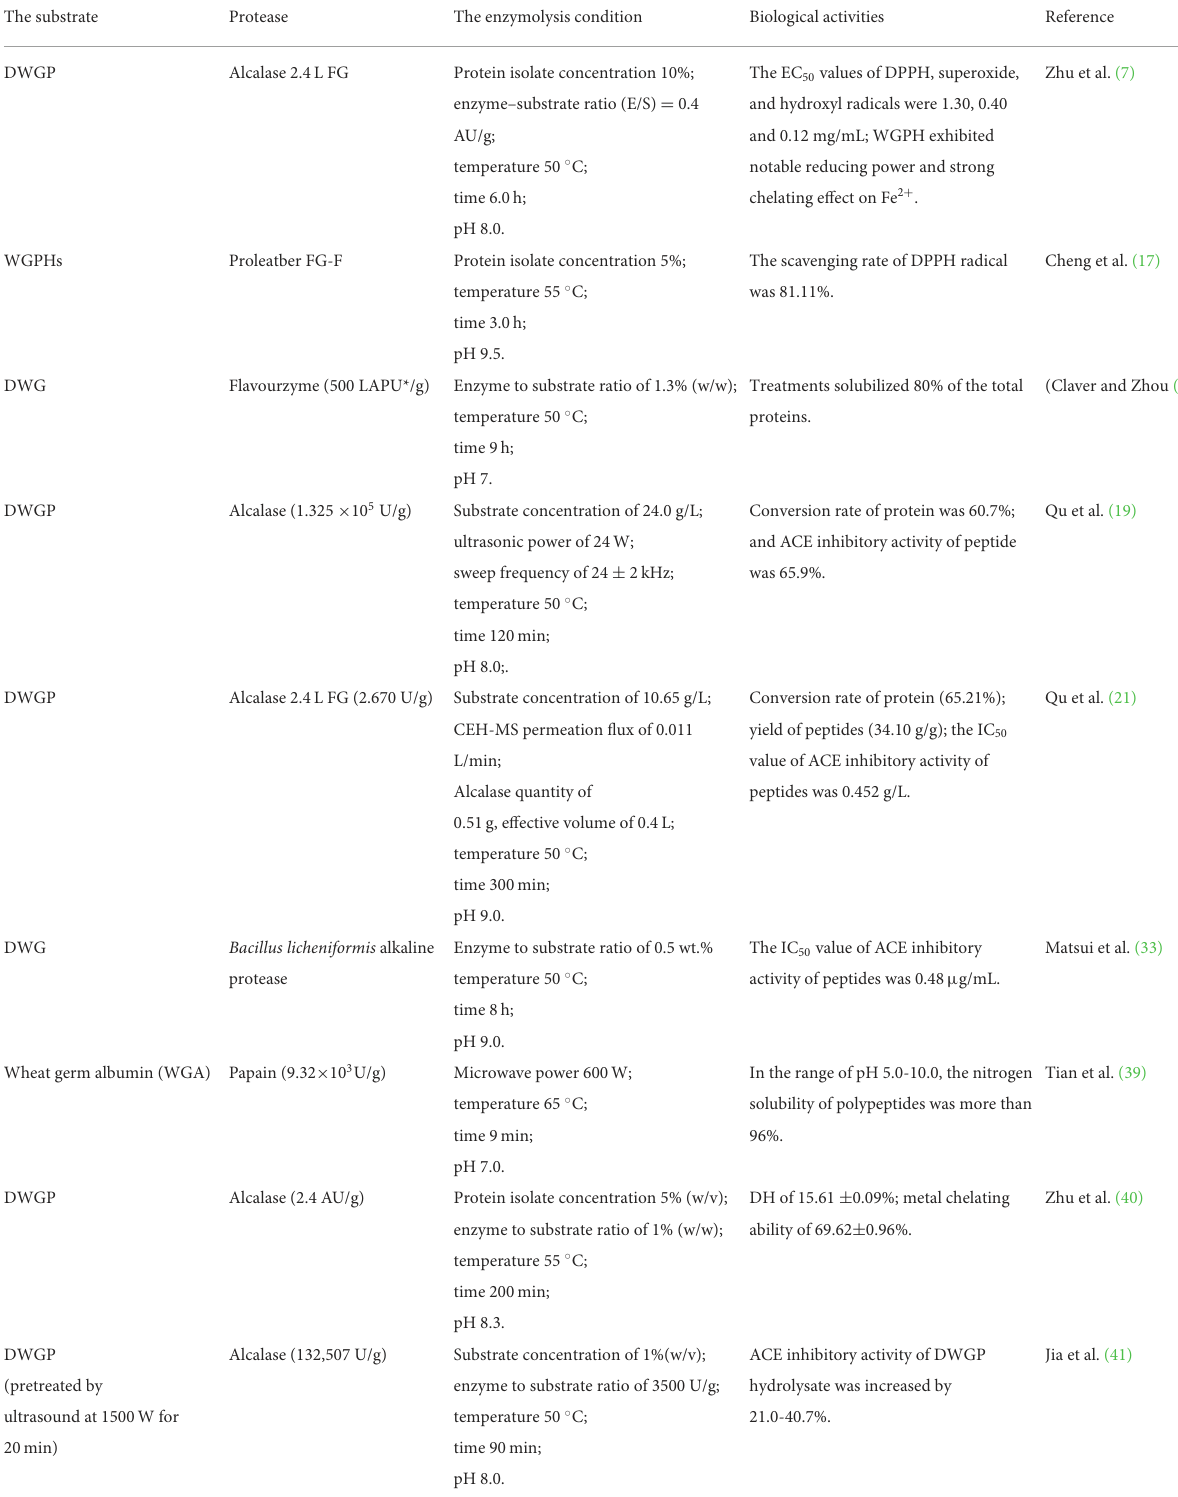
TABLE 1 The enzymolysis of wheat germ protein and biological activities of